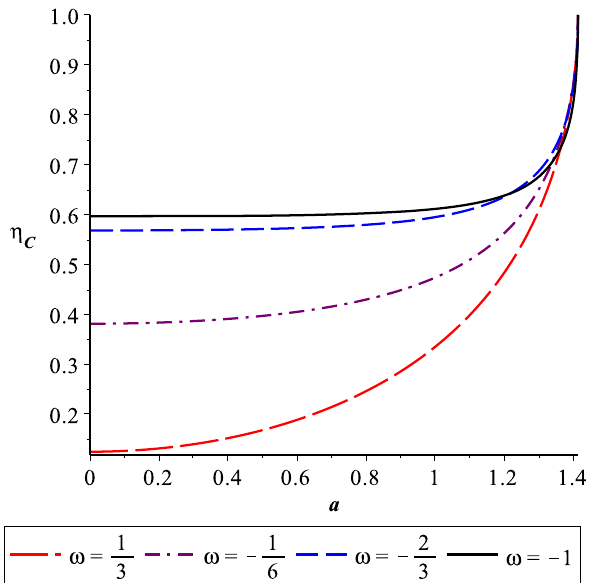
Fig. 10 EfficiencyoftheblackholeasaCarnotheatengine, η C ,versus the quantum correction, a , for different fluids. Values of the thermody- namic quantities are ˜ S C = 4, P C = 0 . 01 and ˜ S H = 2, P H = 0 . 05